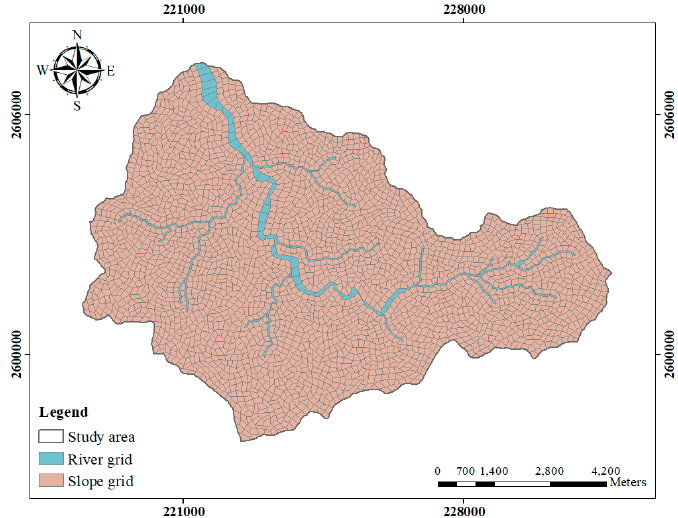
Figure 4. Distributions of the calculation grids for the PHD model analysis.